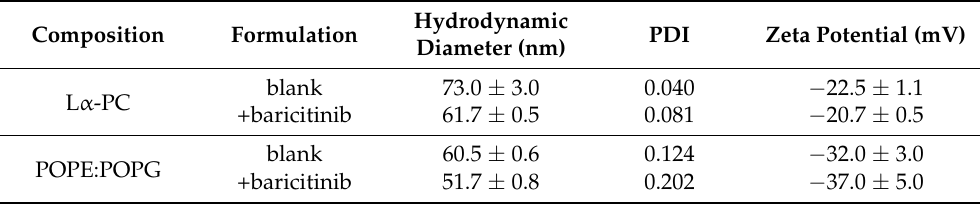
Table 5. Liposome composition with their respective hydrodynamic diameter, polydispersity index (PDI), and zeta potential (ZP). Results are expressed by mean ± SD (n = 3). Composition